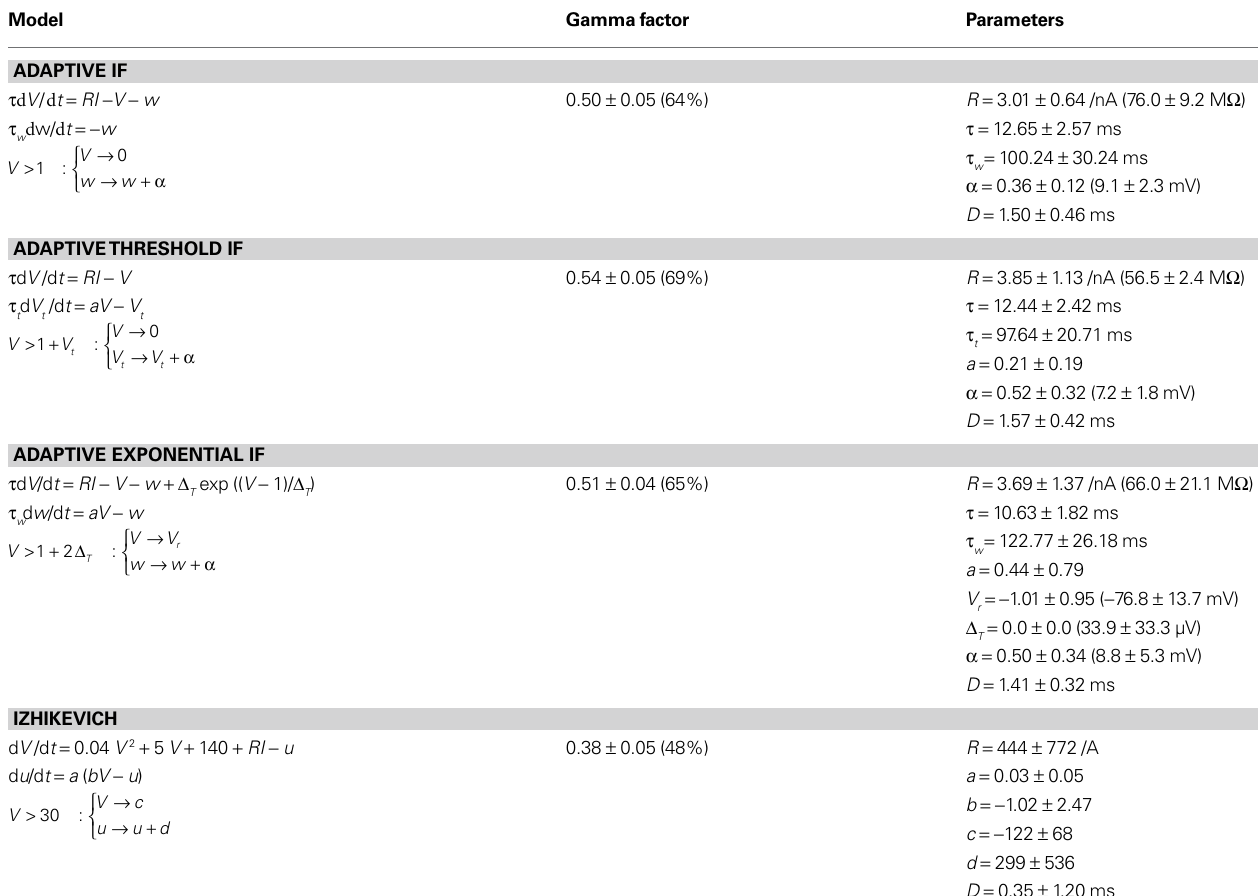
Table 1 | Optimization results for Challenge A. Four neuron models were fi tted to the electrophysiological recordings of a regular spiking L5 pyramidal cell responding to in-vivo -like current injection. There were 13 trials with the same input. The models were optimized on the part of the data between 17.5 seconds and 28 seconds and the gamma factors were calculated between 28 and 38 seconds ( δ = 4 ms). The value relative to the intrinsic reliability Γ brackets. Parameter D is a time shift for output spikes (recorded spikes typically occur slightly after model spikes because they are reported at the time when the membrane potential crosses 0 mV). We also reported rescaled versions of the parameter values (in brackets) so that they correspond to electrophysiological